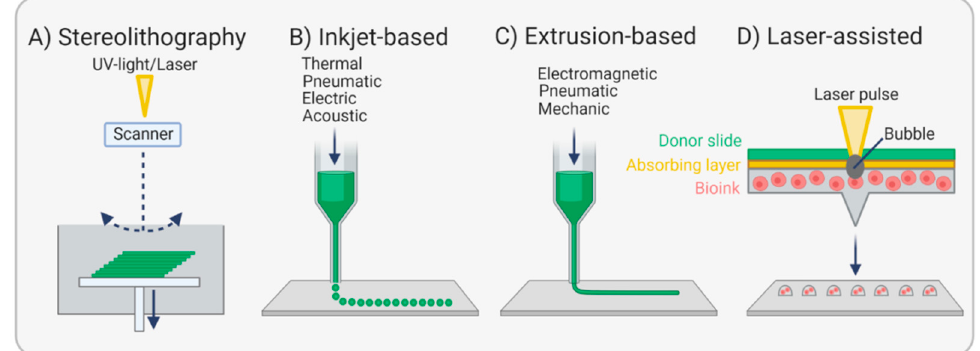
Figure 8. Bioprinting of constructs leading to endothelial basement membrane formation (EBM). Stereolithography is based on photopolymerizable bioinks that polymerize in a layer-by-layer manner in response to light energy ( A ). Inkjet-based bioprinting is a nozzle-based technique printing small drops of bioink ( B ). Extrusion-based printing is also nozzle-based but produces bioink fibers instead of drops. Both Inkjet- and extrusion-based printing can operate with various energy sources ( C ). Laser-assisted bioprinting generates cell-containing hydrogel-based bubbles in a rather gentle procedure ( D ).